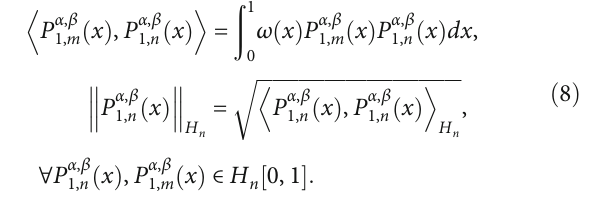
y Þ with n = 1, 2 ⋯ , 7, x ð